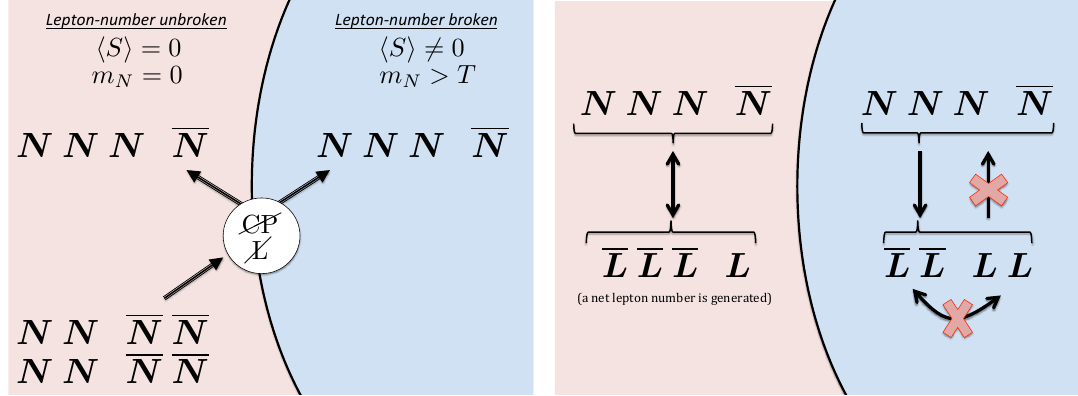
Figure 1 . This cartoon illustrates the stages of the leptogenesis mechanism discussed in the text. Left: the CP-violating scattering of right-handed neutrinos (cid:22) N and left-handed anti-neutrinos N from the bubble wall generates a lepton-number. Right: outside of the bubble, the lepton-number is transferred from N to the SM left-handed leptons L i via lepton-number-preserving interactions. Inside of the bubble, lepton-number-violating interactions are out of equilibrium, and the lepton asymmetry is not washed